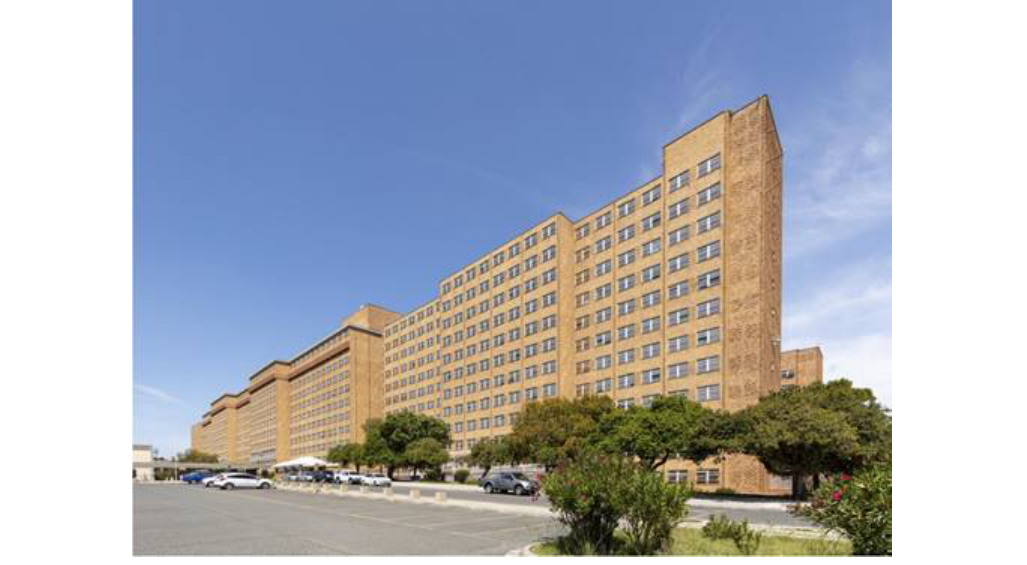
Figure 9. The north façade of the main block of the Tygerberg Hospital, Cape Town (Source: François Swanepoel, 2021, with